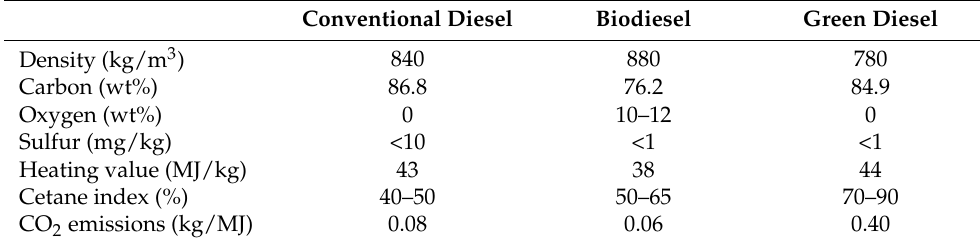
Table 1. Comparison of the main characteristics of diesel, biodiesel and green diesel [26,27,29]. Conventional Diesel Biodiesel Green Diesel Density (kg/m 3 ) 840 880 780 Carbon (wt%) 86.8 76.2 84.9 0 10–12